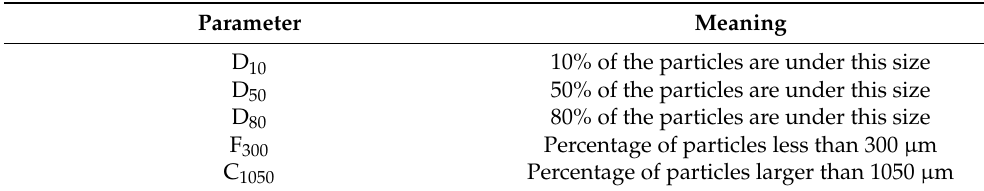
Table 1. Particle size control parameters